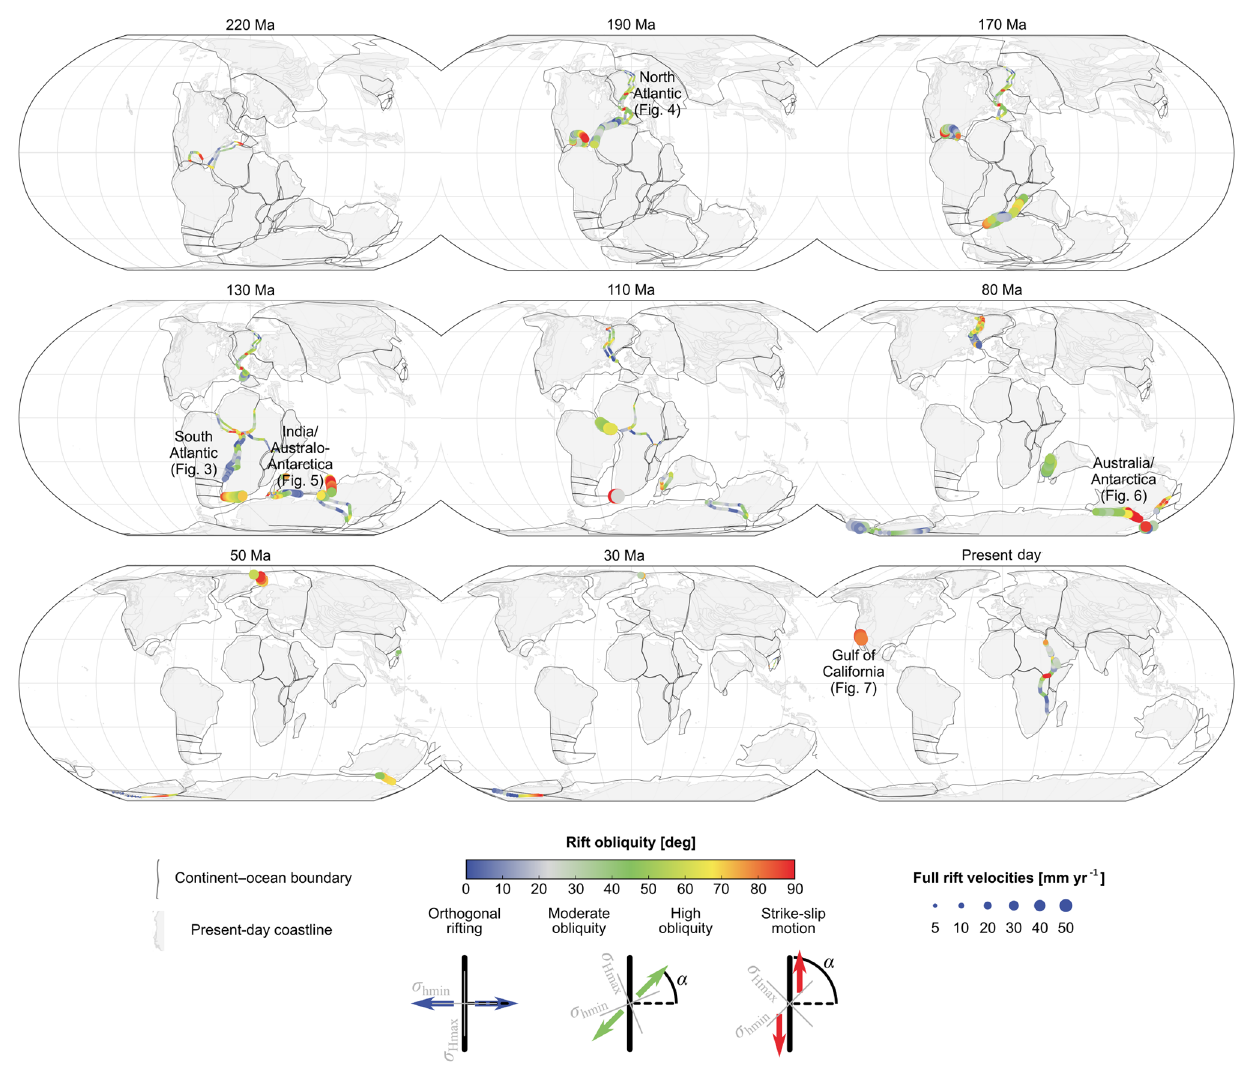
Figure 1. Global overview of rift obliquity and velocity. Rift obliquity is measured as angle α spanned by the relative plate velocity vector and the rift trend normal. Rift kinematics are deduced at sample points along the present-day continental boundaries with a spacing of 50km. Rift velocity magnitude is represented by circle size (see scale in the lower right corner), rift obliquity by circle colour (see colour bar in the middle). The impact of rift obliquity on the rotation of largest and smallest horizontal stress components ( σ Hmax and σ hmin , respectively) is depicted at the bottom of the figure and is based on relations discussed in Brune (2014). Rotations from Müller et al. (2016). Continent–ocean boundaries from Brune et al.